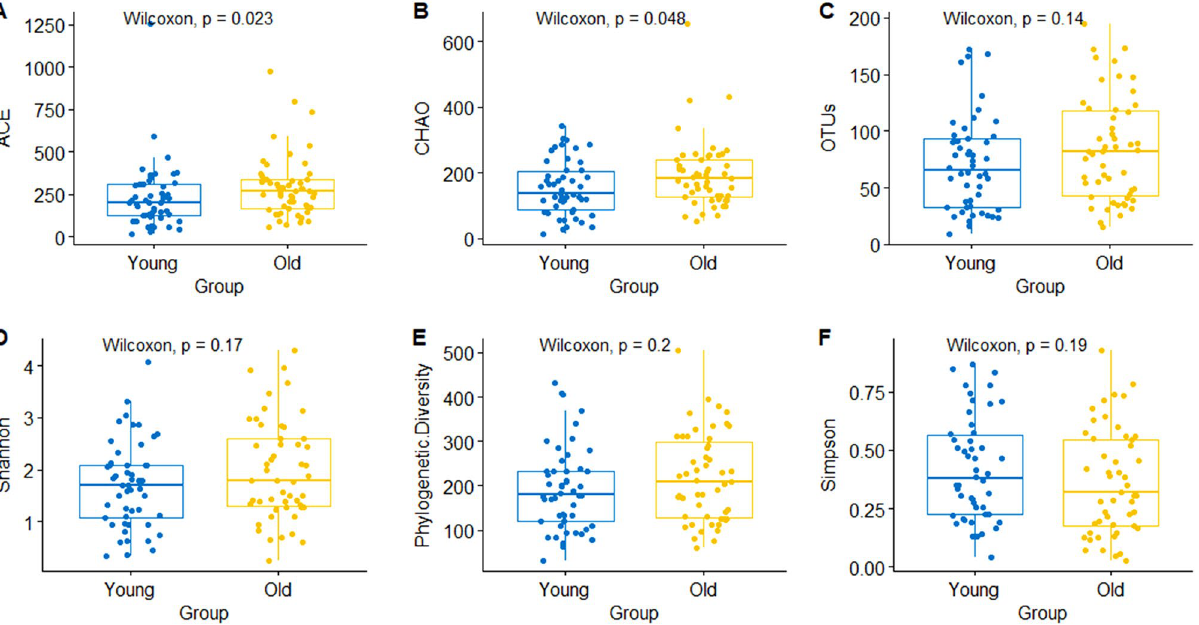
Figure 1. Alpha-diversity comparison between the younger (young) and older (old) groups. ( A ) Abundance- based coverage estimator (ACE); ( B ) Chao1-estimated OTU number; ( C ) OTUs; ( D ) Shannon’s diversity; ( E ) phylogenetic diversity; (F) Simpson’s Diversity Index. Wilcoxon signed-rank test was used for statistical analysis. P values are displayed in the figures.